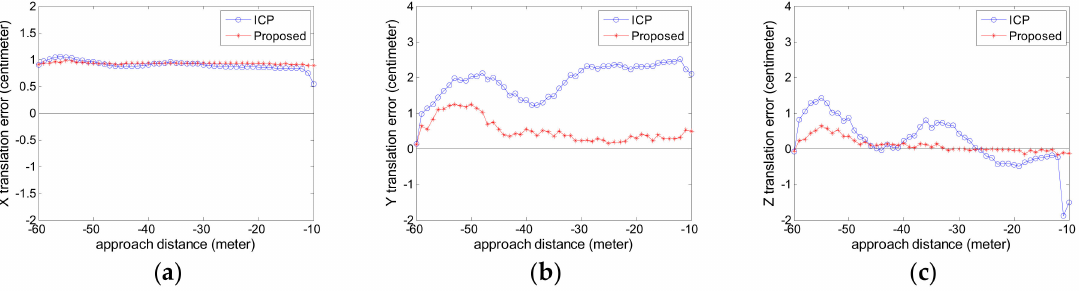
Figure 11. The position error curve in Experiment 2 ( a ) X translation error; ( b ) Y translation error; ( c ) Z translation error.